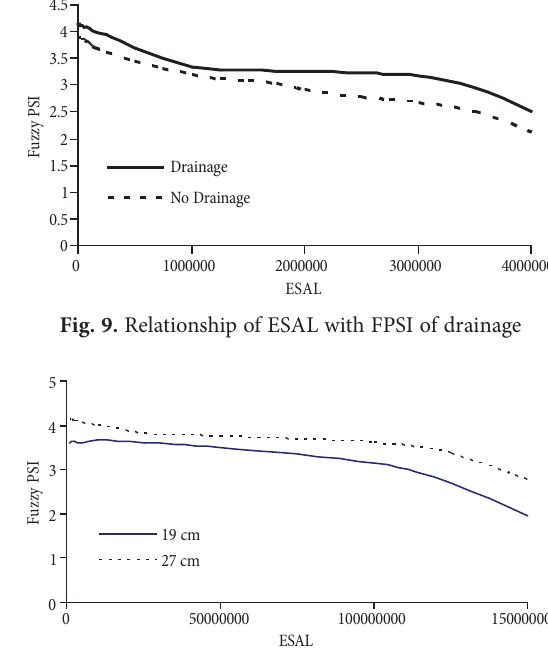
Fig. 10. Relationship of ESAL with FPSI of various layer thicknesses values